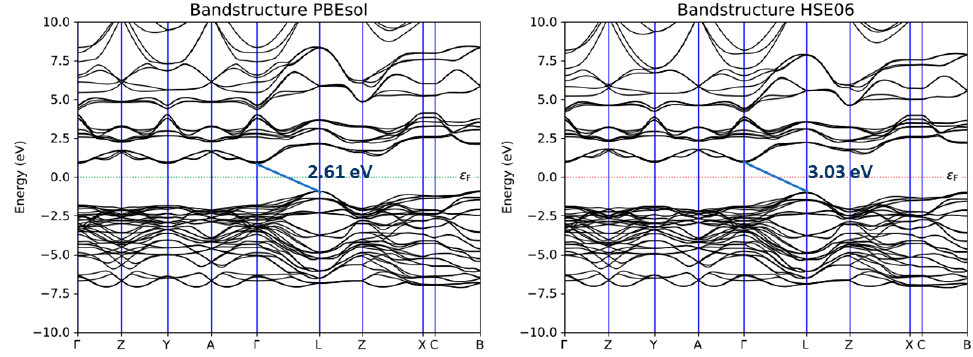
Figure 4. Band structure of MoO 3 calculated with PBEsol and HSE06 functionals.